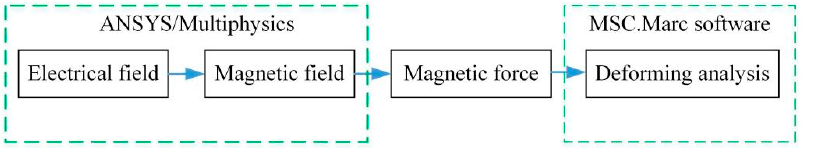
Figure 8. Simulation progress by loosely couple combination of ANSYS with MSC.Marc